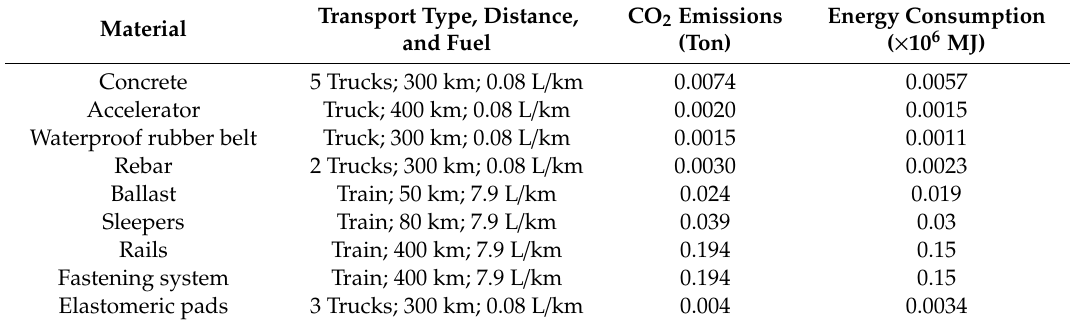
Table 11. Transportation